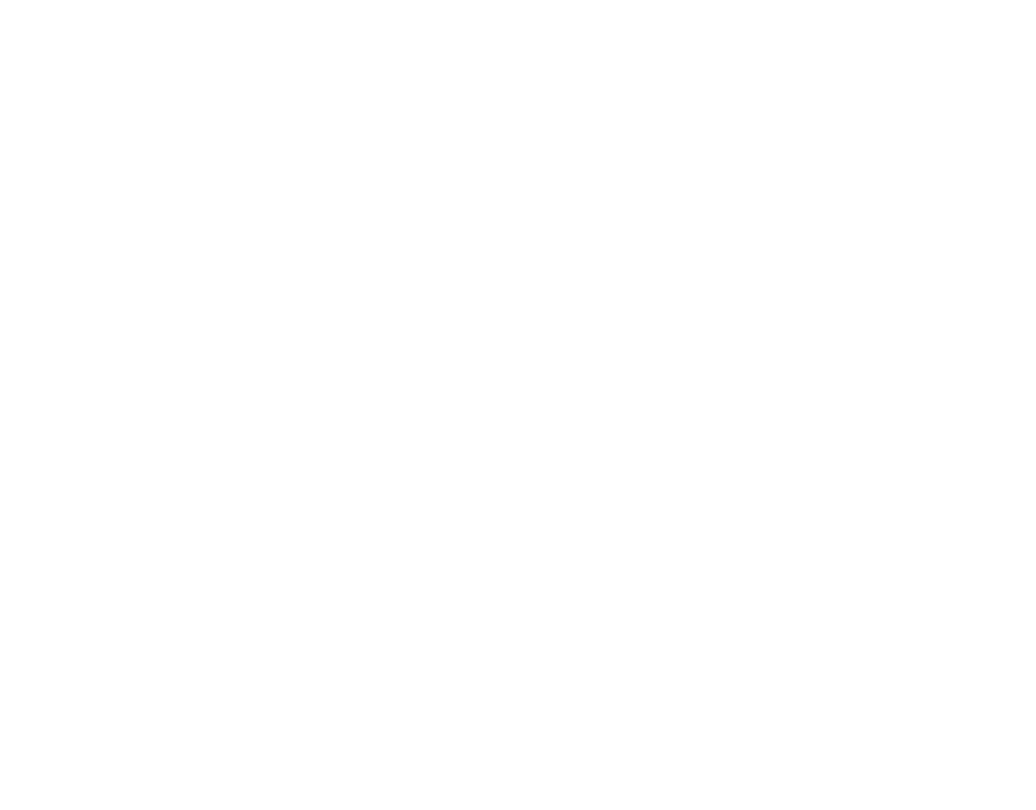
FIGURE A1 | Modeled (lines) and measured (points) gas phase concentrations of oxygen ( (cid:4) ), NO ( • ), and N 2 O ( (cid:2) ) during experiments at 1% initial oxygen concentration in headspace with